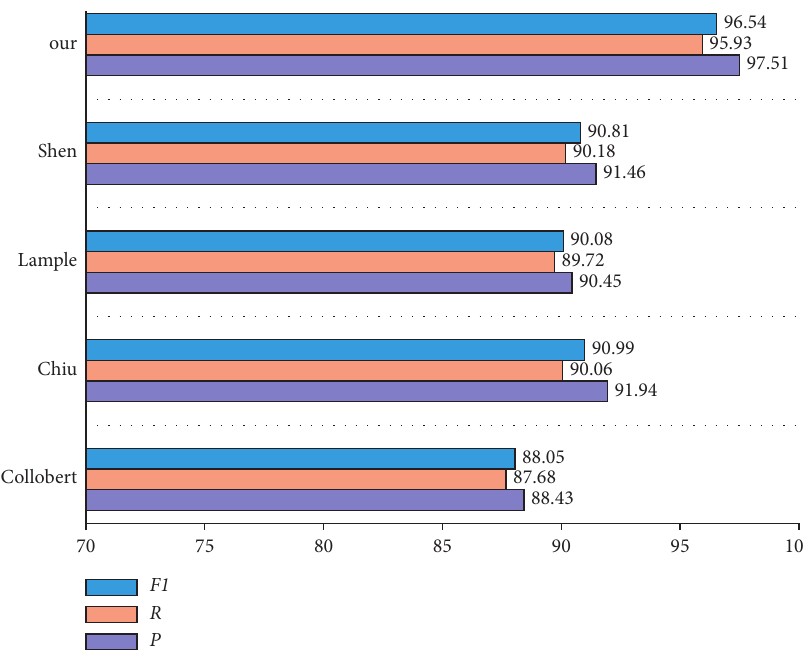
Figure 11: F 1, R , and P comparison of different methods on China People’s Daily